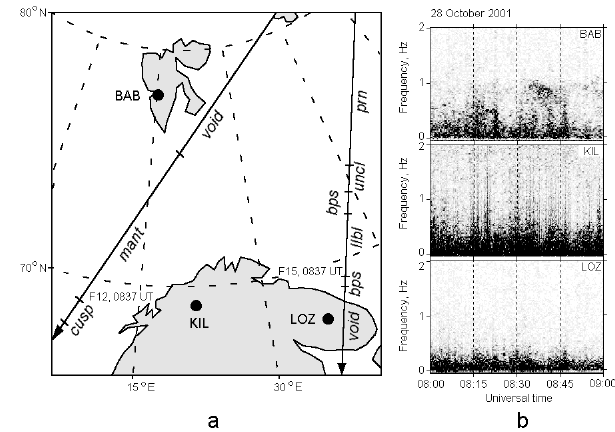
Fig. 3. ( a ) The location of the magnetic observatories BAB, KIL and LOZ are filled circles with the magnetospheric regions from DMSP F12 and F15 overlaid. ( b ) The spectrogram of ULF activity recorded at these